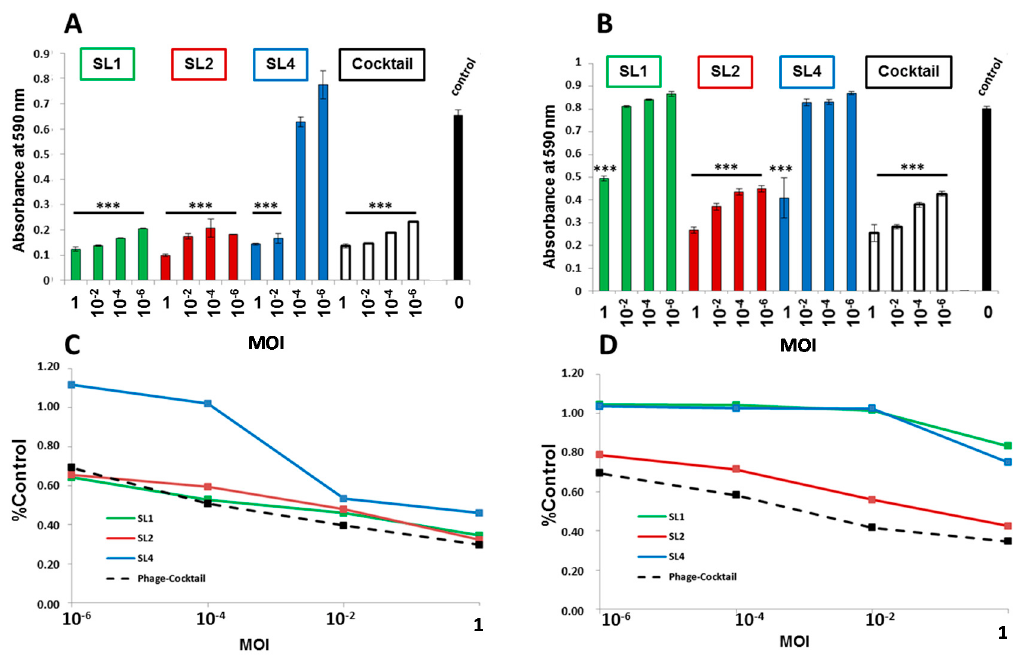
Figure 8. Reduction of multi-drug resistant P. aeruginosa strains: MDR-PA1 ( A , C ); and MDR-PA2 ( B , D ) in liquid medium after 16 h treatment with phages SL1, SL2, and SL4 in liquid culture using four different MOIs. ( A , B ) OD 590 -values after 16 h incubation with phage; and ( C , D ) area under the curves divided by the area under the curve of the control; Each experiment was performed in triplicate and the means ± standard errors are indicated. Statistical significance of bacterial reduction (compared to the control) was assessed by performing Student’s t -test. p -Values refer to the control: *** p < 0.001, ** p < 0.01, * p < 0.05.